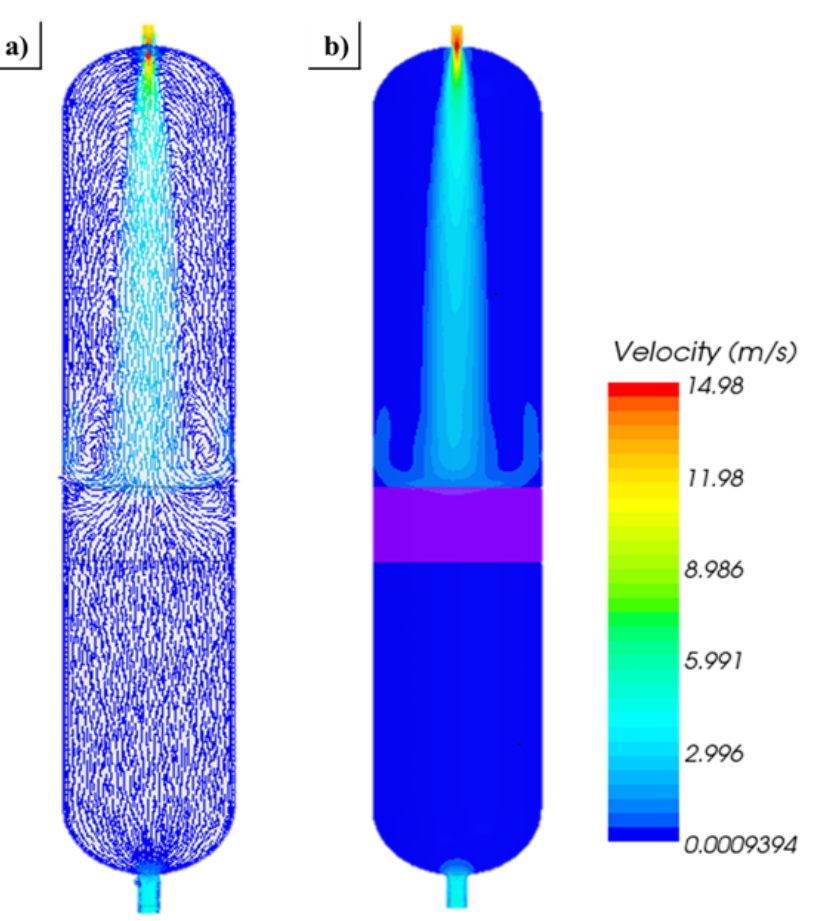
Figure 1. Velocity plot by cold-flow analysis: ( a ) velocity vector fields and ( b ) velocity magnitudes.